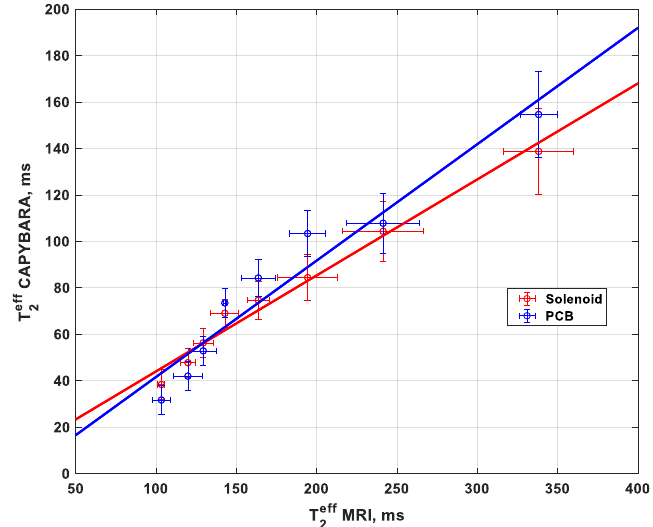
Figure 6. T 2eff measurements using solenoid and PCB coil with a unilateral system (NMR CAPIBarA) compared to the clinical MRI T 2eff measurement.